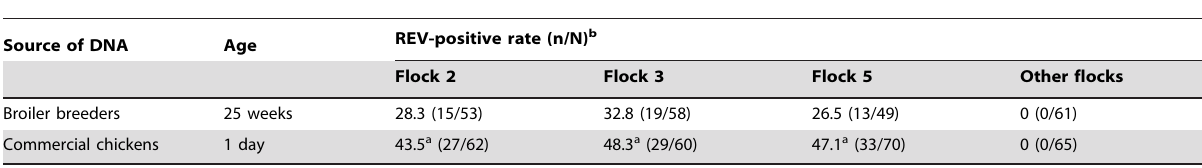
Table 1. REV-positive rates of DNAs from spleen tissues in different generations (%).